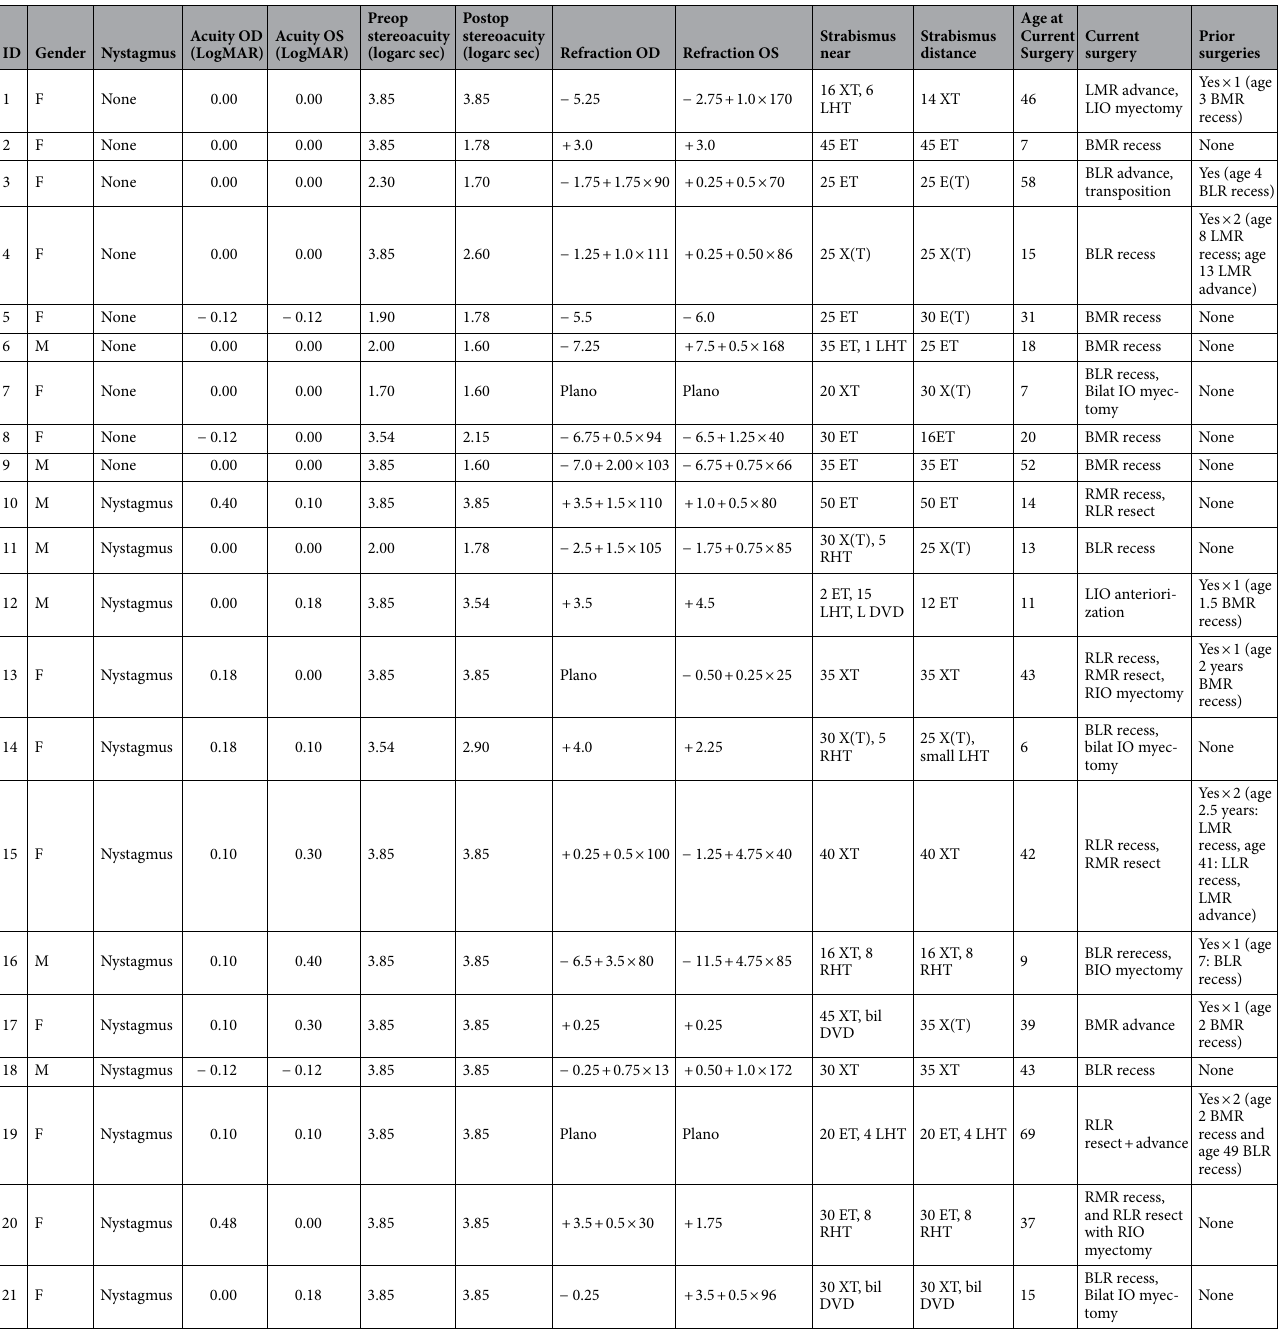
Table 1. The clinical and demographic features of subjects included in the study. F female, M male, ET esotropia, XT exotropia, DVD dissociated vertical deviation. () = intermittent deviation. HT hypertropia, LR lateral recti muscles, MR medial recti muscles, IO inferior oblique. (Preceded by B- Bilateral, L- Left, R- Right). We report the strabismus angle, stereoacuity, monocular visual acuity measured at the time of eye movement recordings before and after strabismus